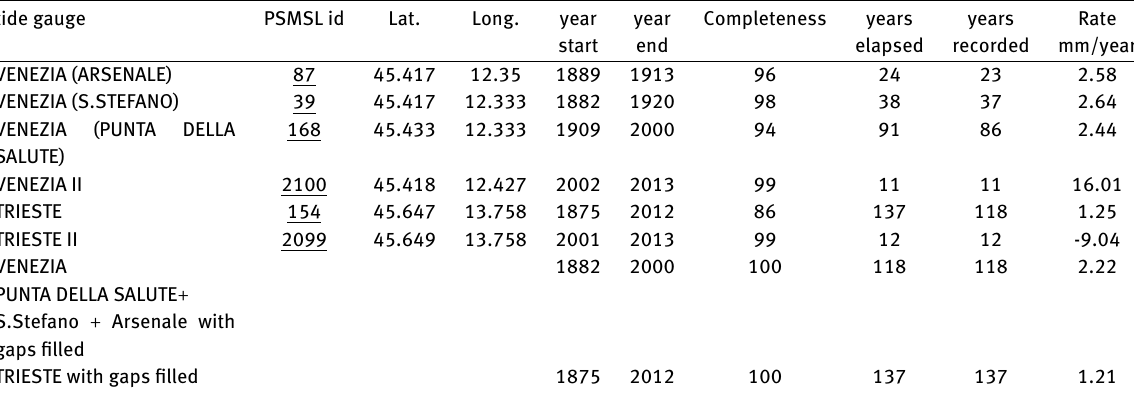
Table 1. MSL data for Trieste and